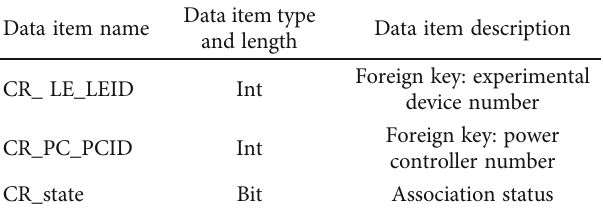
Table 3: Data structure of the control association